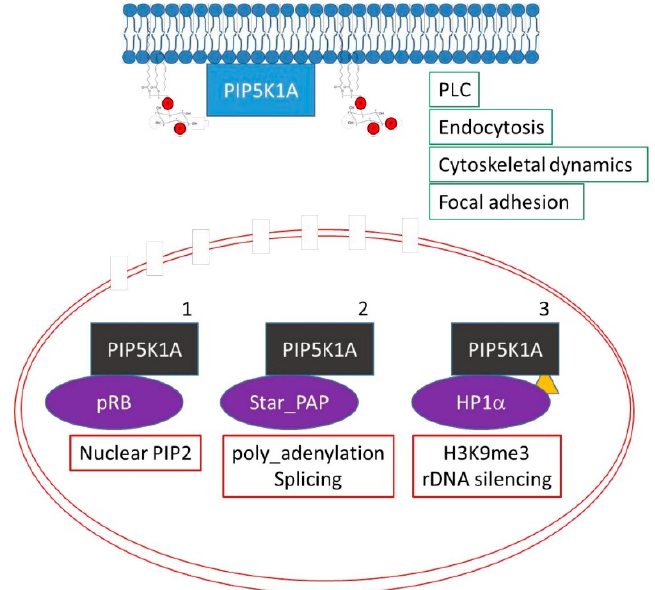
Figure 4. Three different mechanisms for localising PIP5K1A to the nucleus are shown. PIP5K1A has roles in the cytoplasm (blue) and can translocate into the nucleus (black). The change in the colour of PIP5K1A depicts changes in binding partners or in post translational modifications that enable nuclear localisation (the red lines depict the double nuclear membrane with some nuclear pores). The yellow triangle depicts sumoylation of PIP5K1A which has been shown to target PIP5K1A to the nucleus.